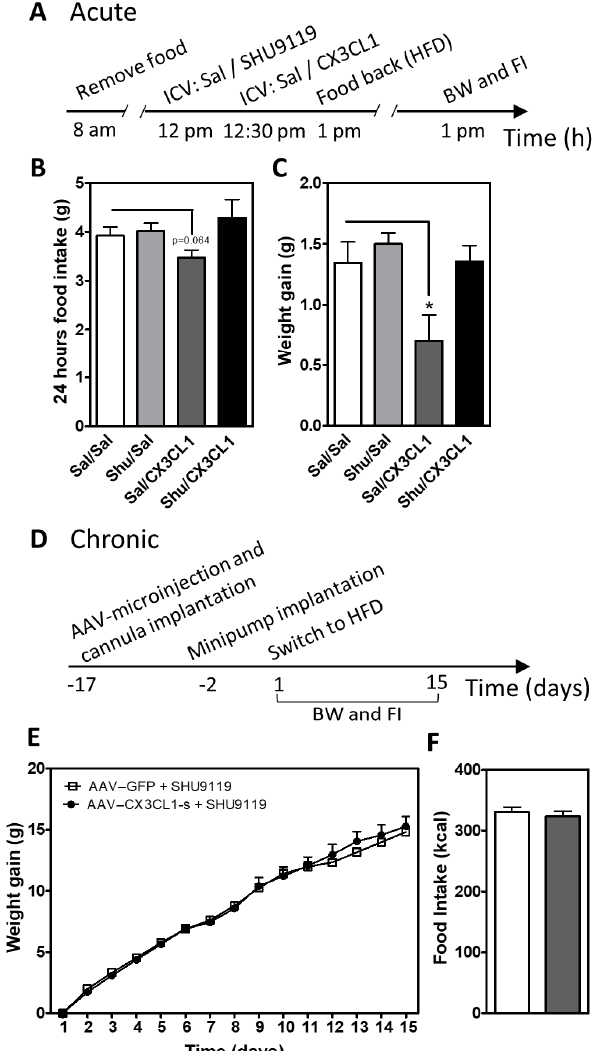
Figure 4. Central CX3CL1 does not reduce weight gain and food intake in mice treated with MC3R/MC4R antagonist . ( A ) Time scale of the experimental approach used for acute i.c.v. administration of SHU9119 and CX3CL1. ( B , C ) Average of cumulative 24 h food intake ( A ) and body weight gain ( B ) in mice treated with saline (Sal) or SHU9119 i.c.v. and 30 min later with Sal or CX3CL1 i.c.v. Data are presented as mean ± SEM of at least 5 animals per group. * p < 0.05. ( D ) Time scale for chronic i.c.v. administration of SHU9119 in mice previously subjected to hypothalamic viral microinjection of AAV–GFP and AAV–CX3CL1. ( E , F ) Body weight gain ( E ) and total food intake ( F ) measured in mice with hypothalamic overexpression of CX3CL1-s or GFP control that received SHU9119 i.c.v. infusion over 2 weeks (compare with Figure 1D). Data are presented as mean ± SEM